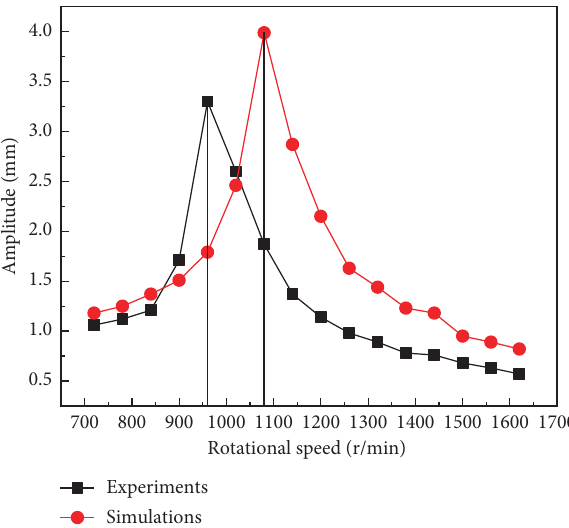
Figure 9: Amplitude comparison between experiment and sim- ulation under different rotational speeds. Figure 10: Amplitude of the disc spring system under three dif- ferent eccentric masses.